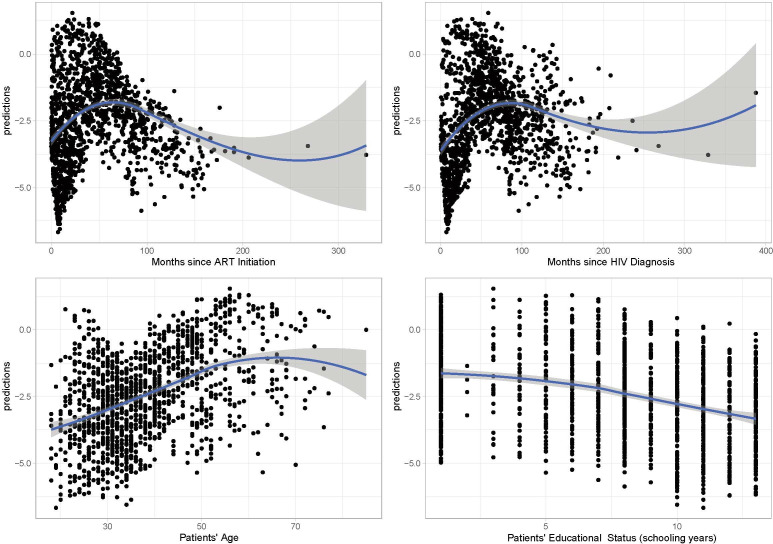
Heterogeneity plots for household assets.